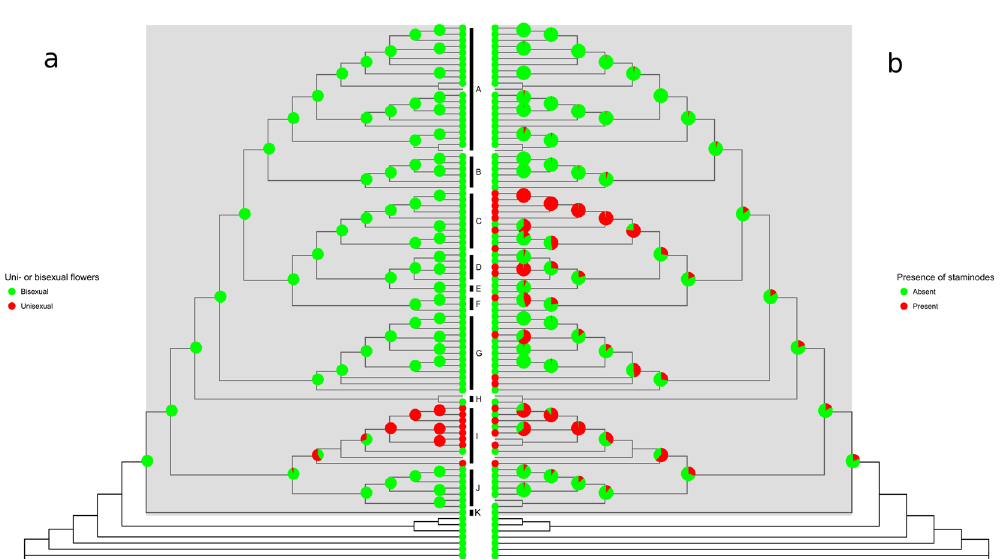
Figure 5. Presence of uni- or bisexual flowers ( a ) and presence of staminodes ( b ) plotted on the Monanthotaxis phylogeny. Pie charts show inferred